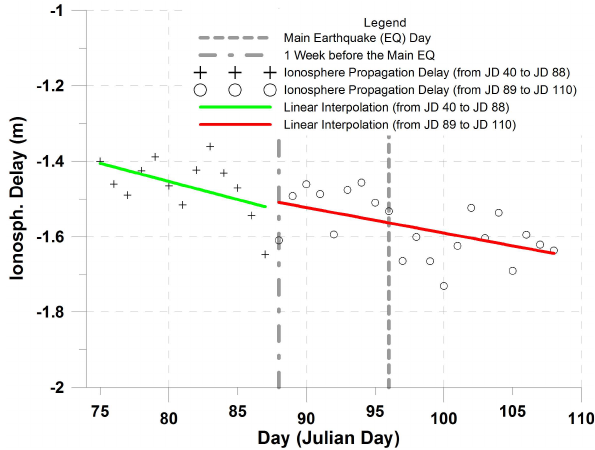
Fig. 9. Time series of the ionospheric delay in CDRA–PRN